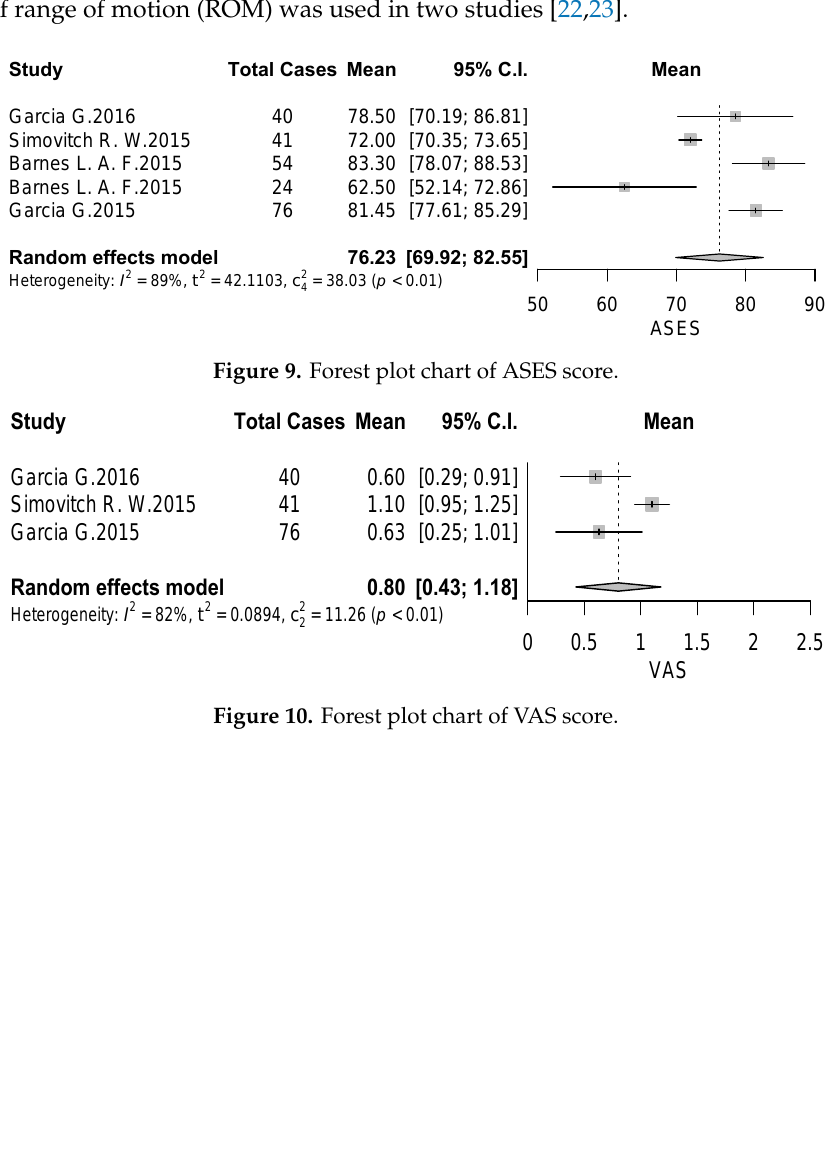
Table 4. Rehabilitative protocols and surgical approach.